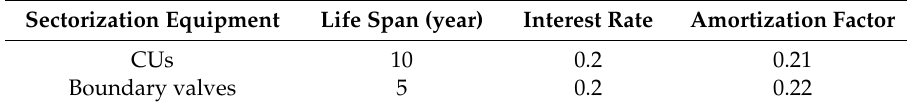
Table 2. Calculation of the amortization factors used in the example of the